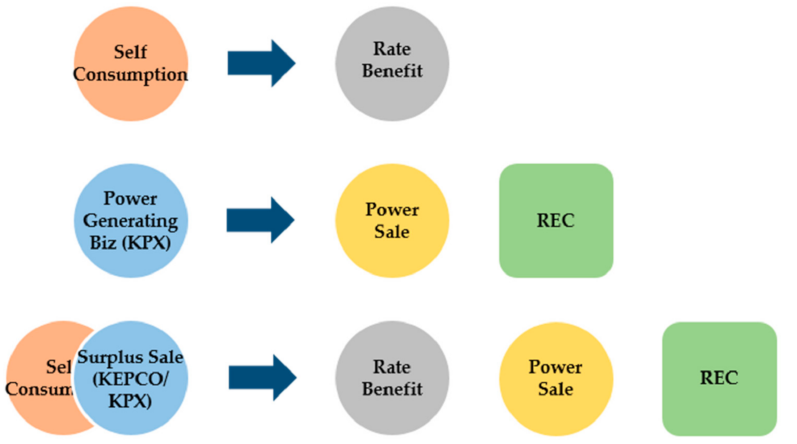
Figure 1. Distributed energy resource (DER) revenue structure according to the type of